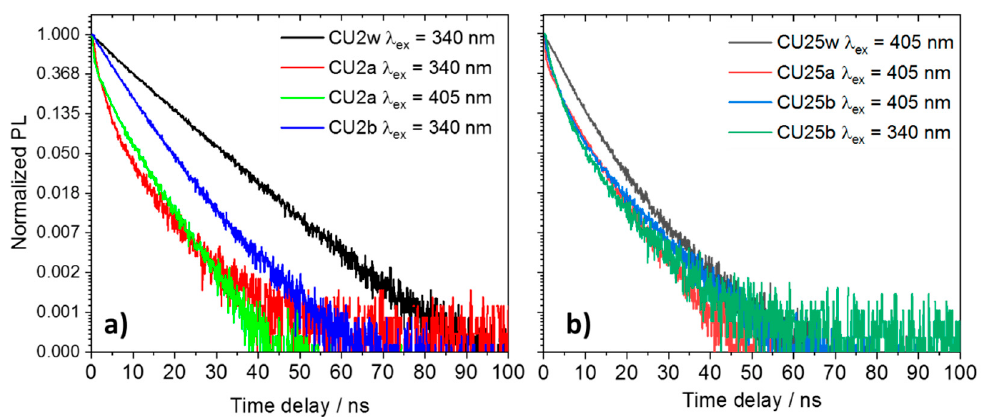
Figure 7. Luminescence decay profile of 100 mg L − 1 C-dots in different aqueous solutions excited with a 340 and 405 nm laser (w = water, a = acid, b = base). ( a ) CU2 and ( b ) CU25.